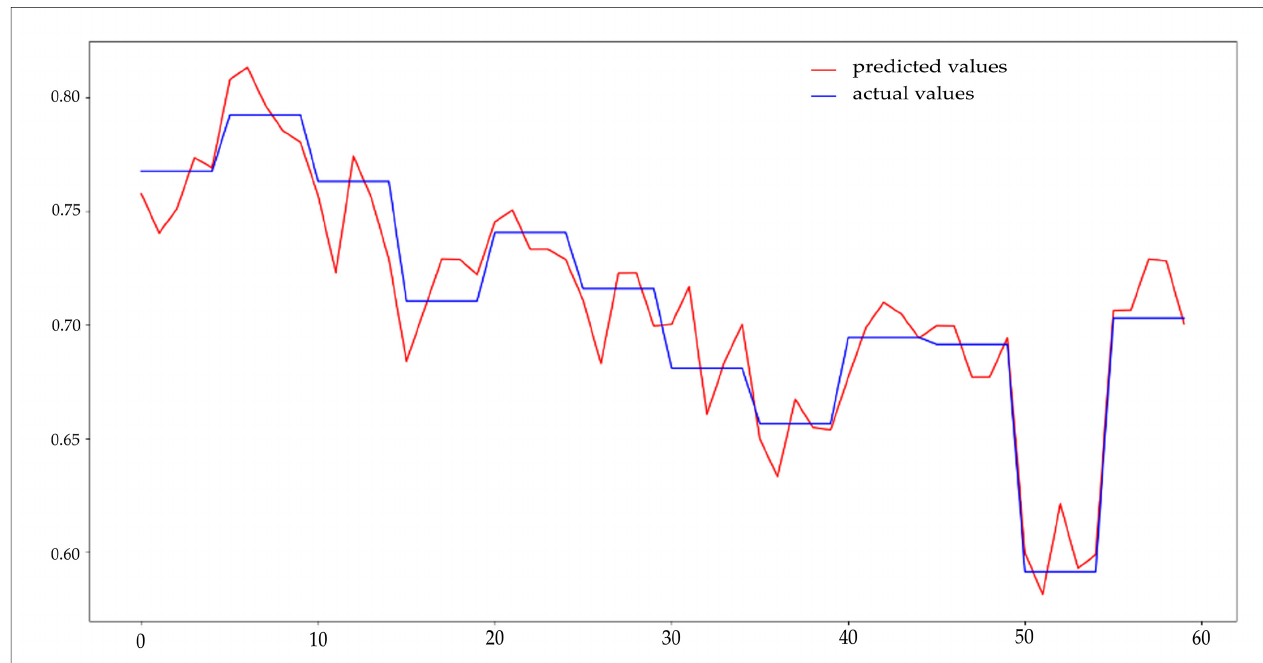
Figure 14. Actual values and values predicted by the ANFIS model—Sigmf (sigmoid) function.